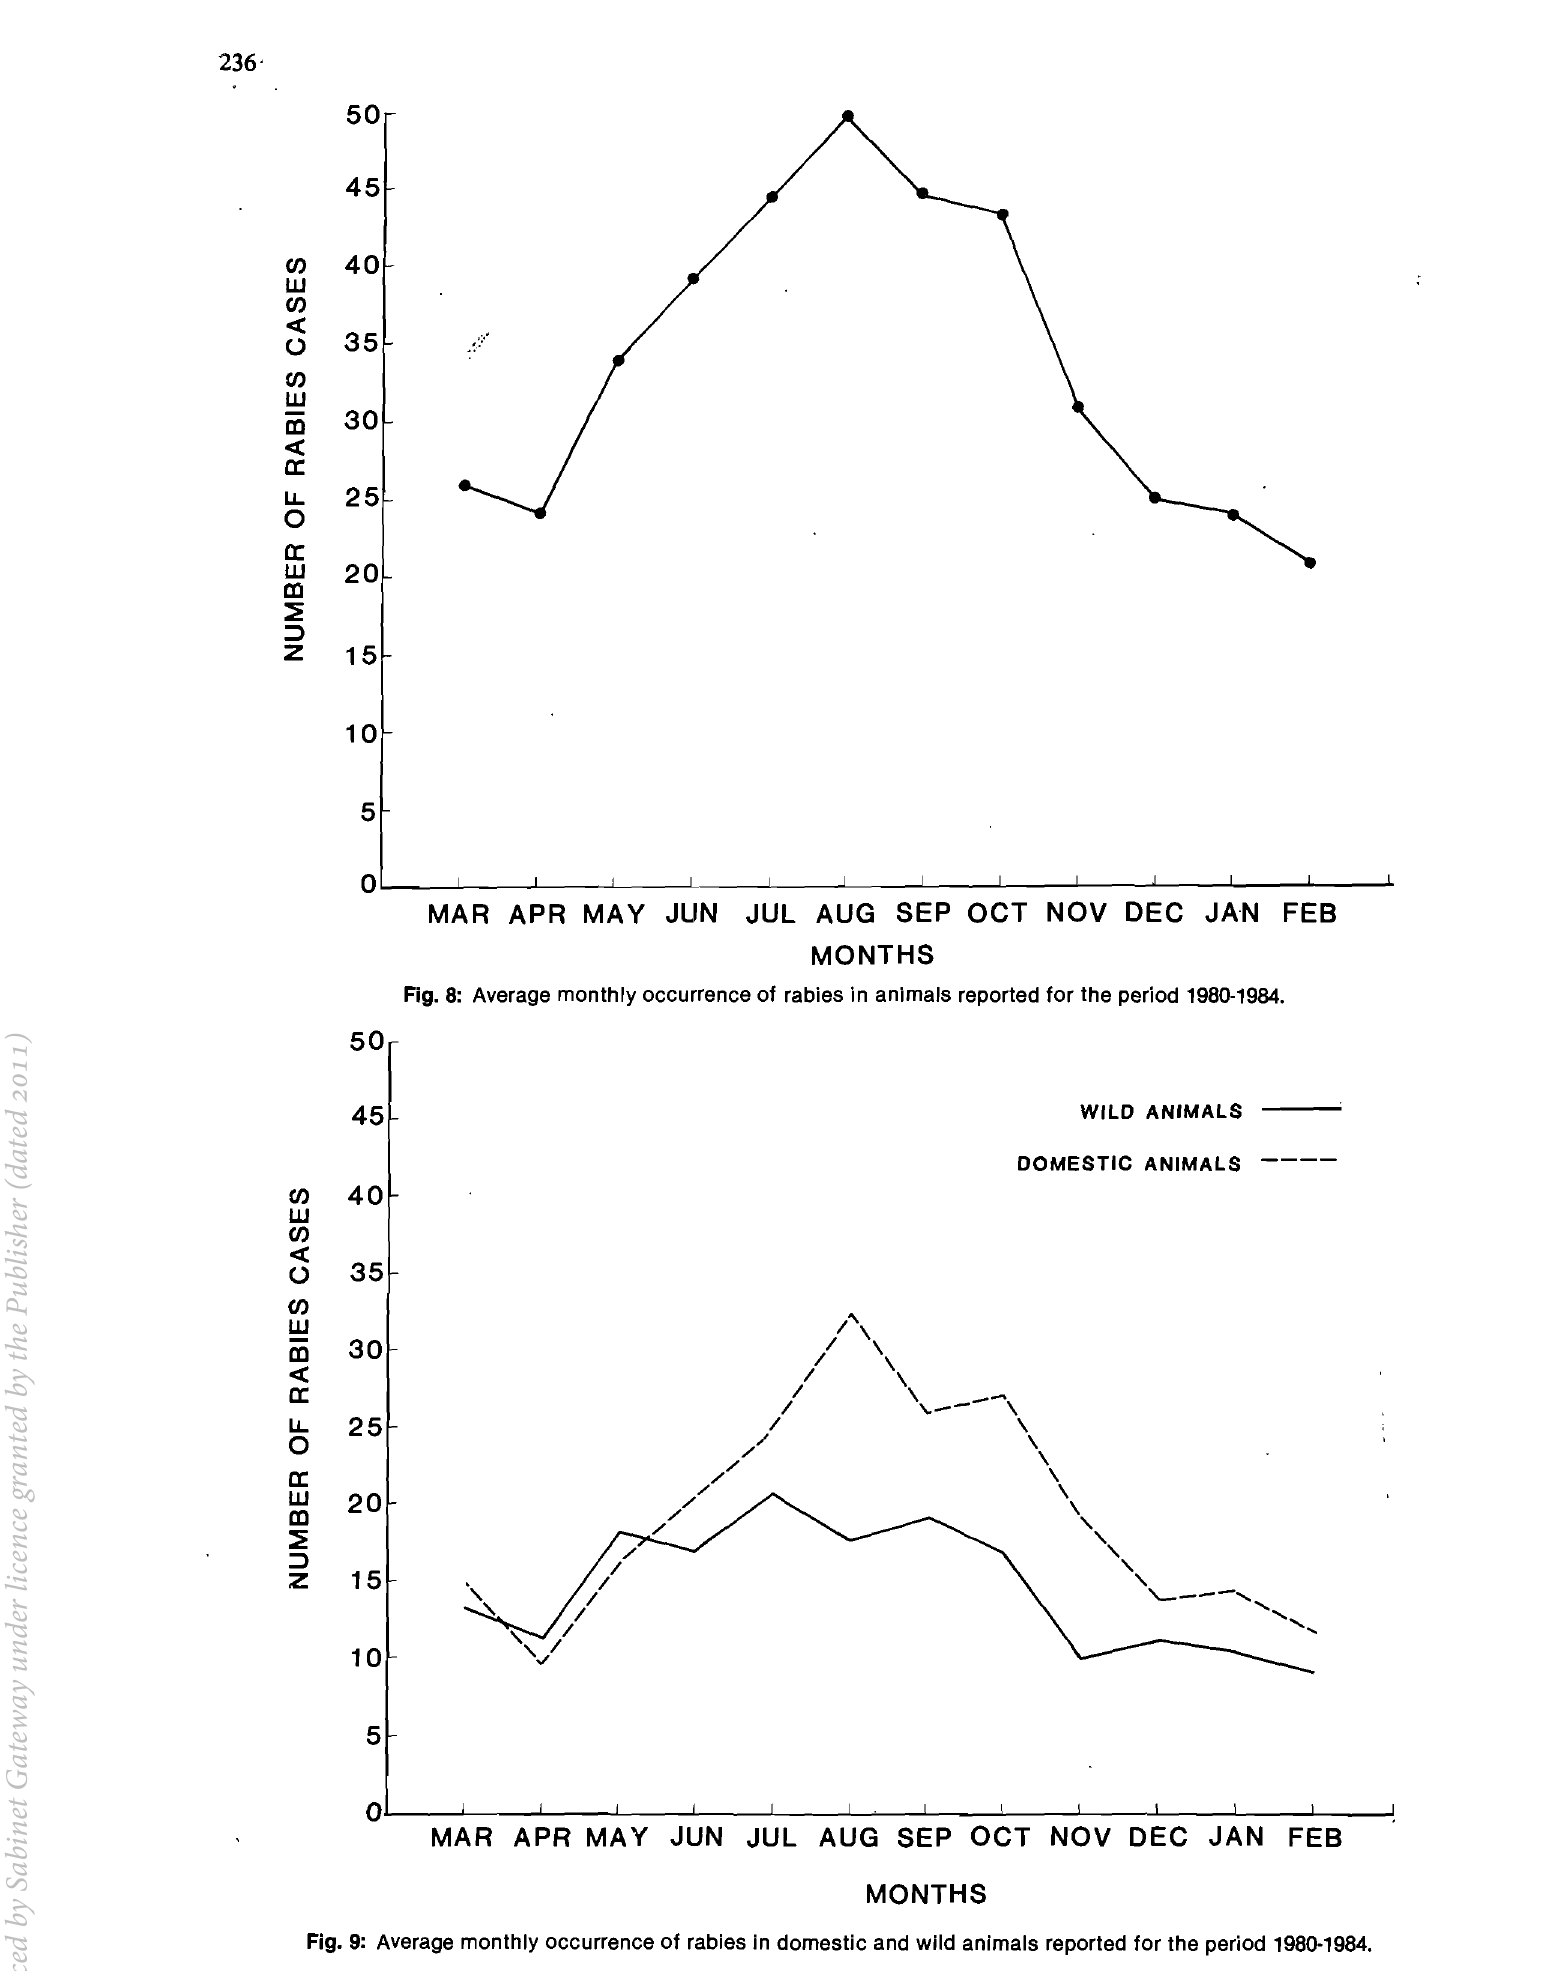
Fig. 9: Average monthly occurrence of rabies in domestic and wild animals reported for the period 1980-1984. TYDSKRIF VAN DIE SUJD-AFRIKAANSE VETERINERE VERENIGING-DESEMBER